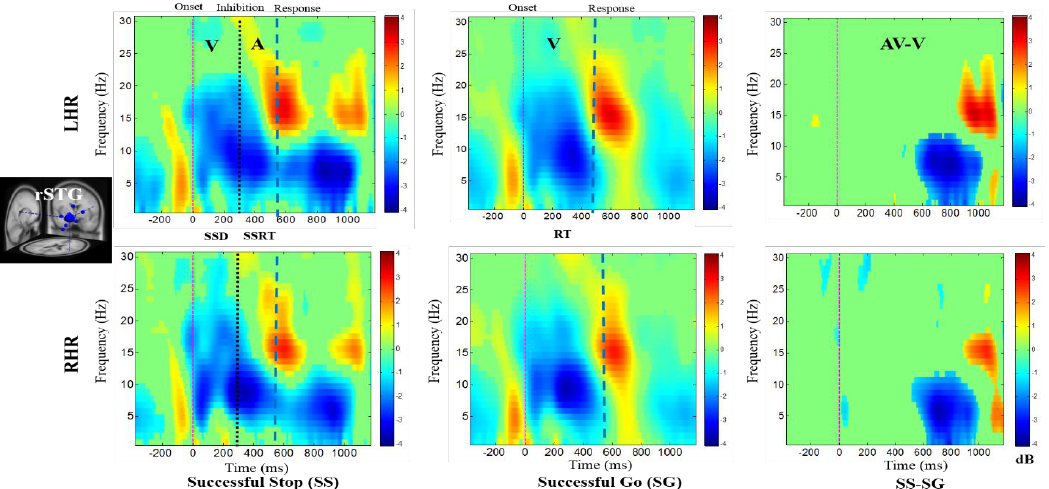
Figure 6. The ERSP plots showing the post-stimuli modulations in right superior temporal gyrus (rSTG) of the brain under combined visual (V) stimuli and auditory (A) alarms. Purple dashed line: Onset of the visual stimuli; black dashed line: Onset of the auditory alarms; blue dashed line: Onset of response. Color bars show the amplitude of the ERSP; statistical threshold at p < 0.01.